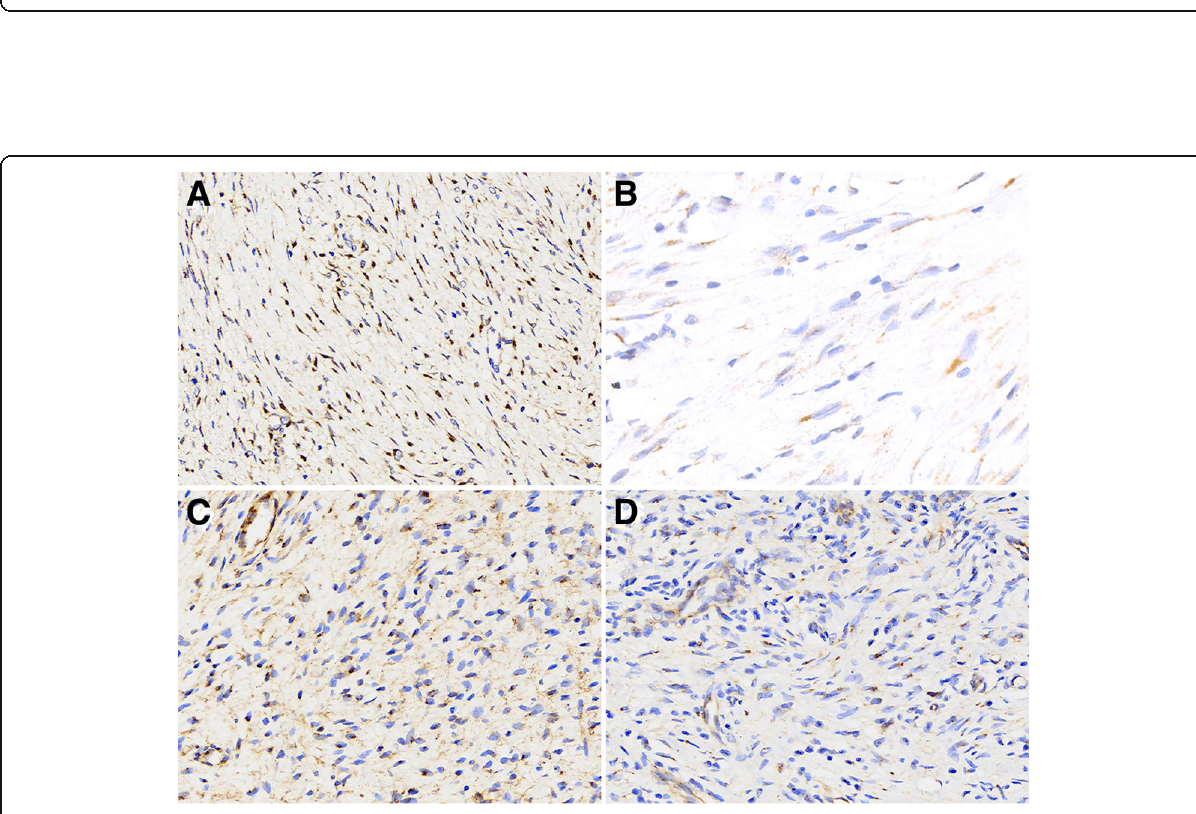
Fig. 2 DTF samples demonstrated positive nuclear β -catenin staining ( a , 400x), while NF, neurofibroma and DFSP samples were all negative for nuclear β -catenin ( b , c and d ,